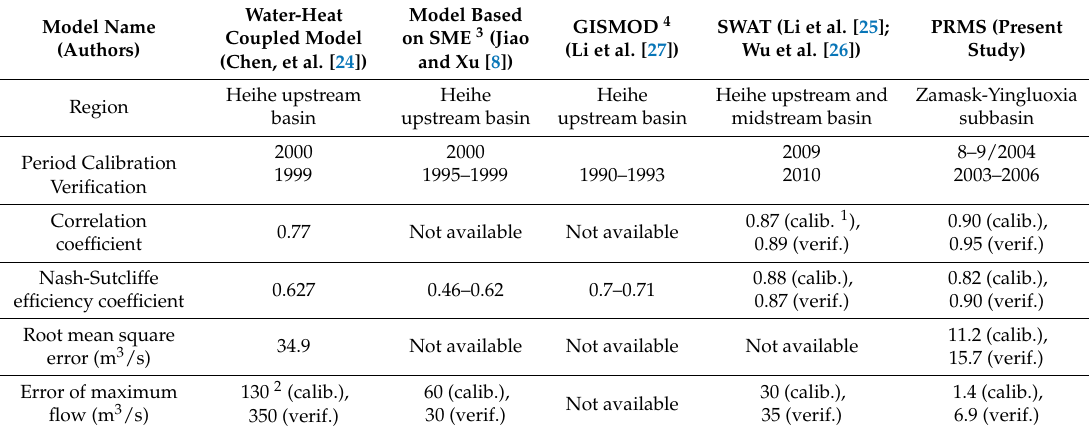
Figure 9. Comparison of measured and estimated flows at Yingluoxia station during the model verification period from 1 January 2003 to 31 December 2006. Table 2. Statistics comparison of model simulations and observations of daily flow at Yingluoxia station by different rainfall-runoff modeling